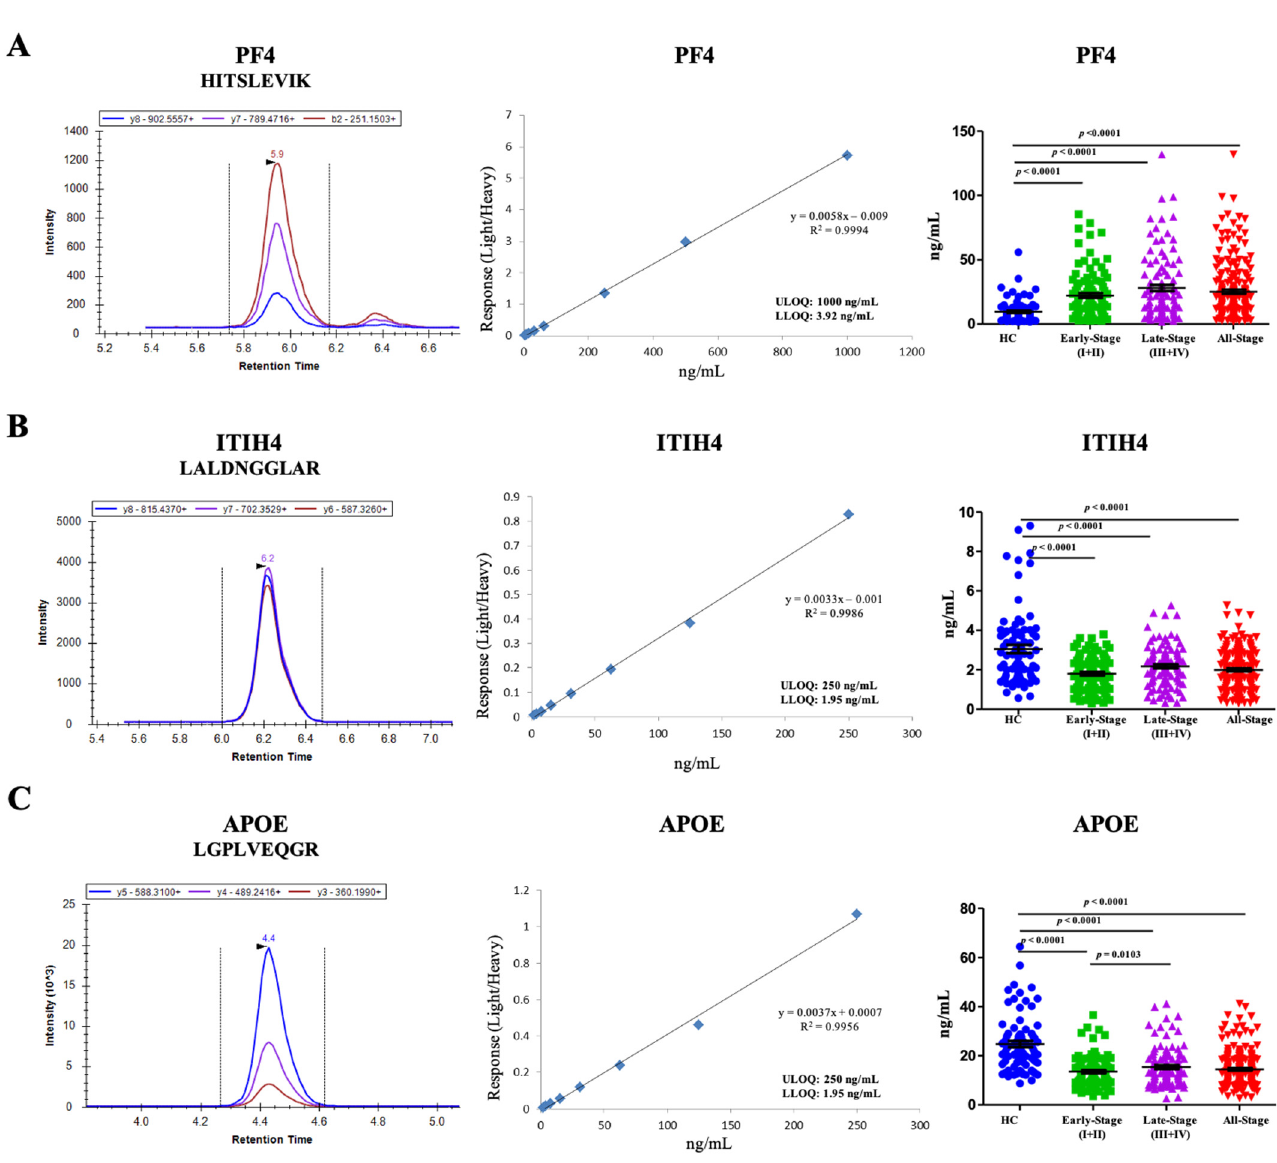
Figure 2. Semi-quantification of peptide factor 4 (PF4) ( A ), inter-alpha-trypsin inhibitor heavy chain H4 (ITIH4) ( B ), and apolipoprotein E (APOE) ( C ) in healthy control (HC), early-stage colorectal cancer (CRC), late-stage CRC, and all-stage CRC groups using an isotope-labeled multiple reaction monitoring (MRM) assay. Extracted ion chromatography (left panel), calibration curves (middle panel), and group comparisons of concentrations (right panel) of the three peptides are demonstrated. The mean value and standard deviation of the peptides corresponding to wheat germ agglutinin (WGA)-captured proteins from HC, early-stage CRC, late-stage CRC, and all-stage CRC groups are shown. The Student’s t -test was used for the pairwise comparisons of the concentration of peptides from the HC, early-stage CRC, late-stage CRC, and all-stage CRC groups. p < 0.0083 was considered statistically significant.